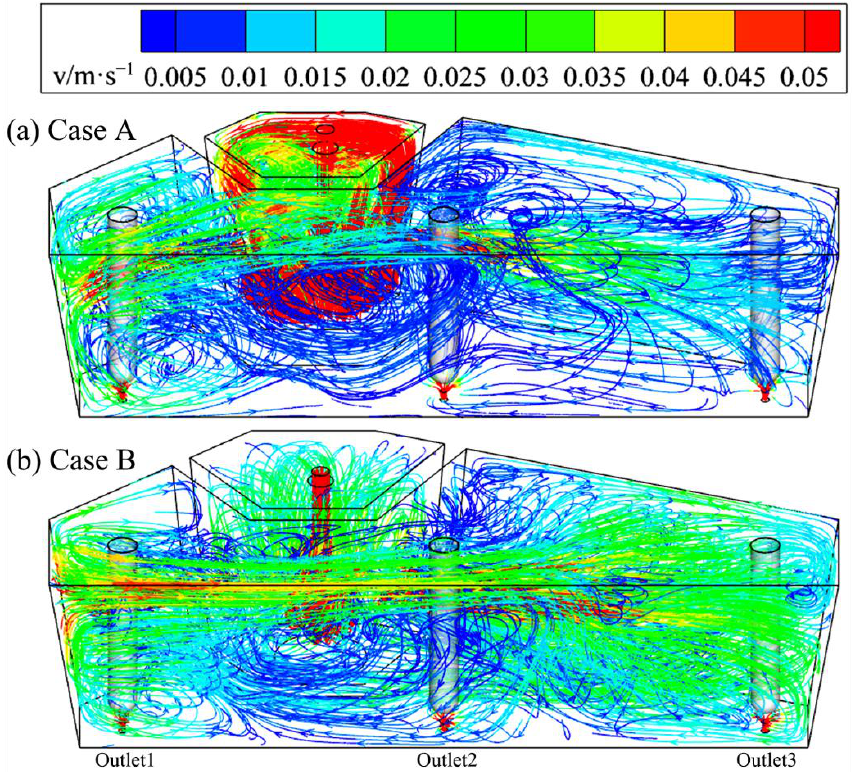
Figure 5. Three-dimensional streamline contours of tundish in cases A ( a ) and B ( b ).